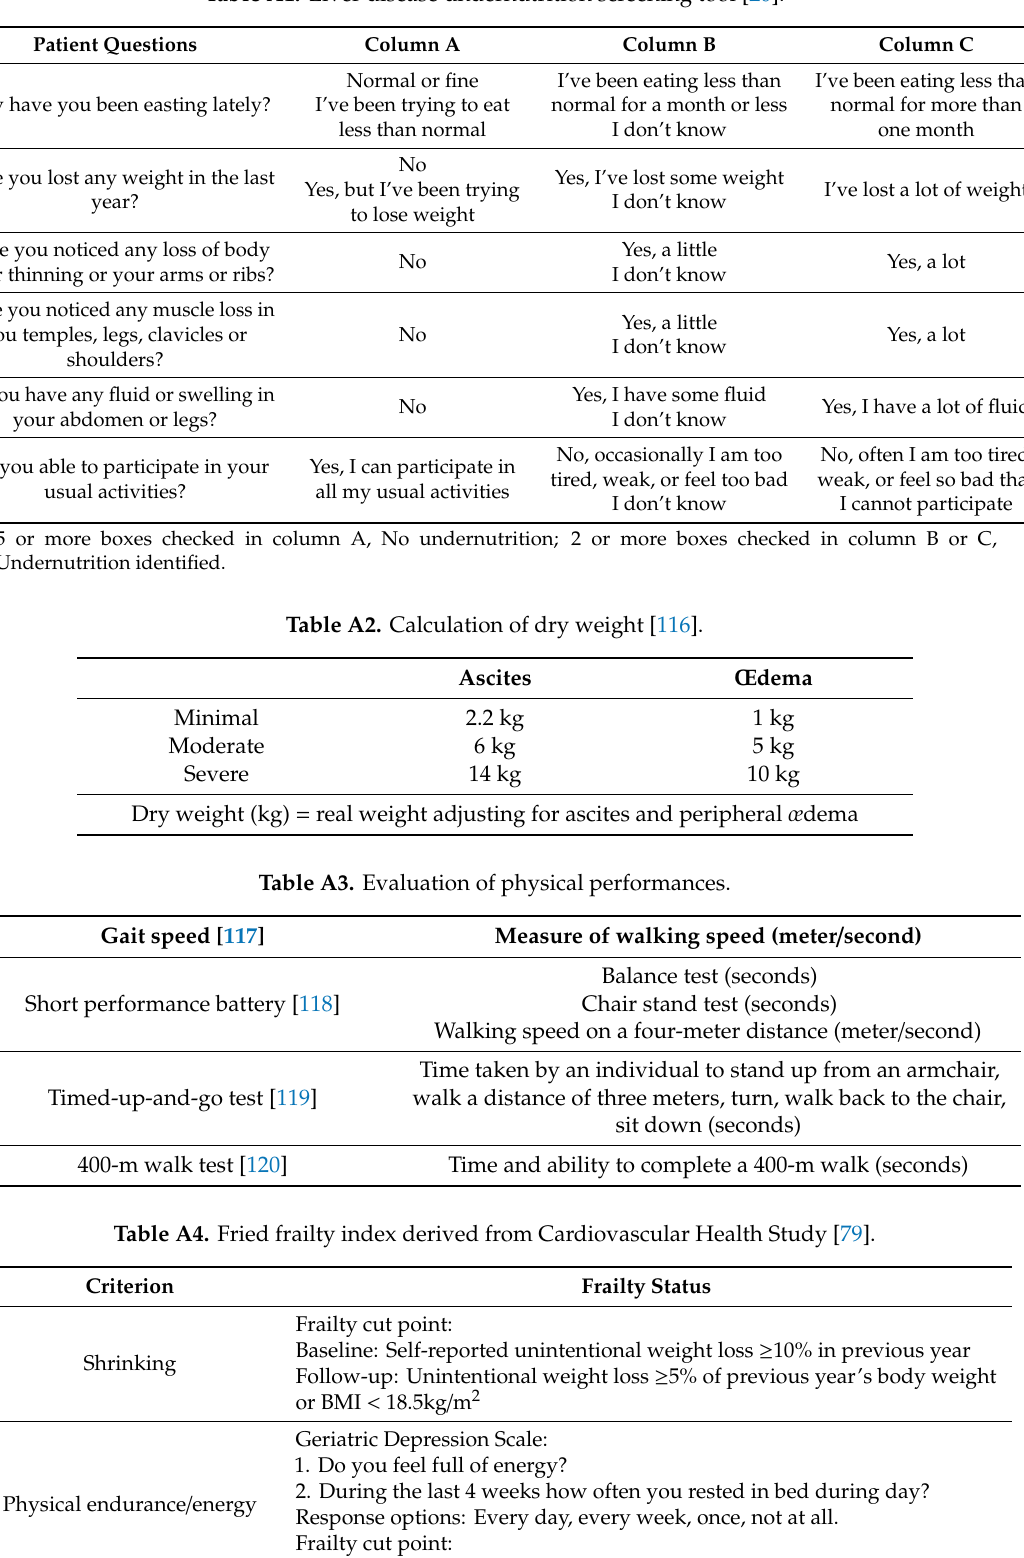
Table A1. Liver disease undernutrition screening tool [20].